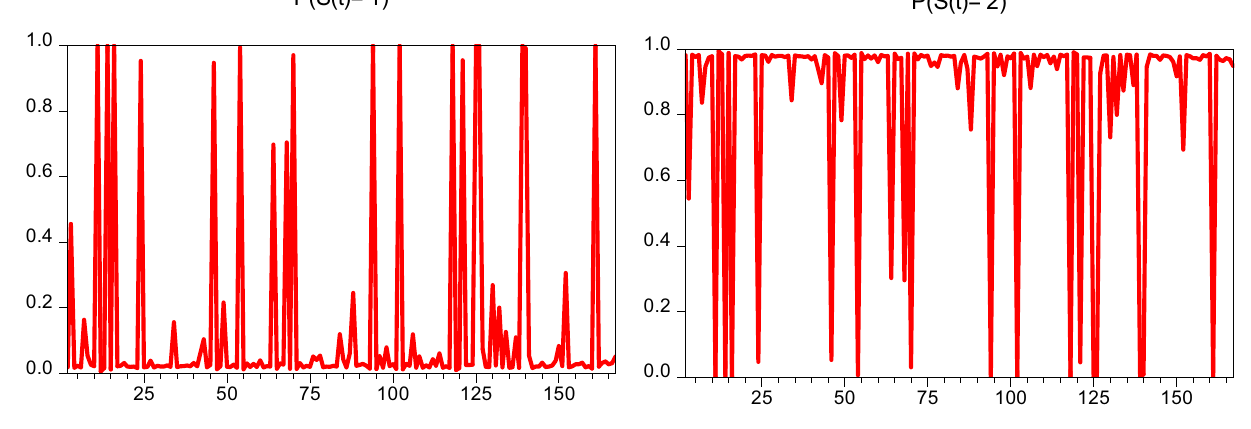
Fig. 1 Level of rainfall spatial variability based on the Markov regime